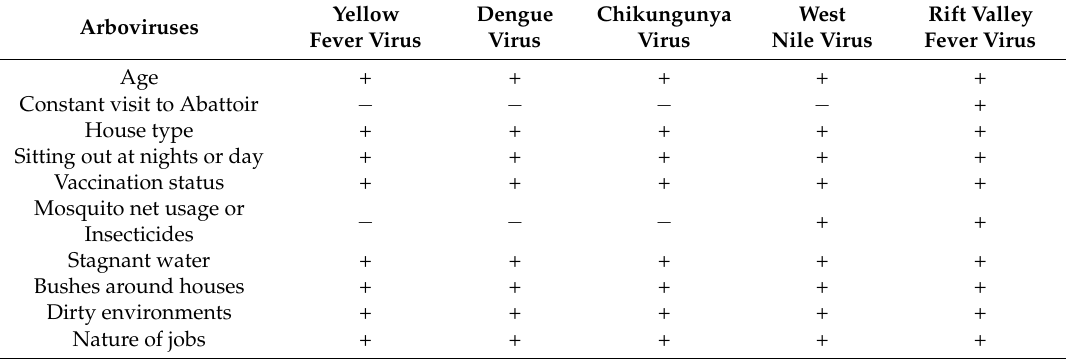
Table 3. Predisposing risk factors to some arboviruses in Nigeria. Yellow Arboviruses Fever Virus